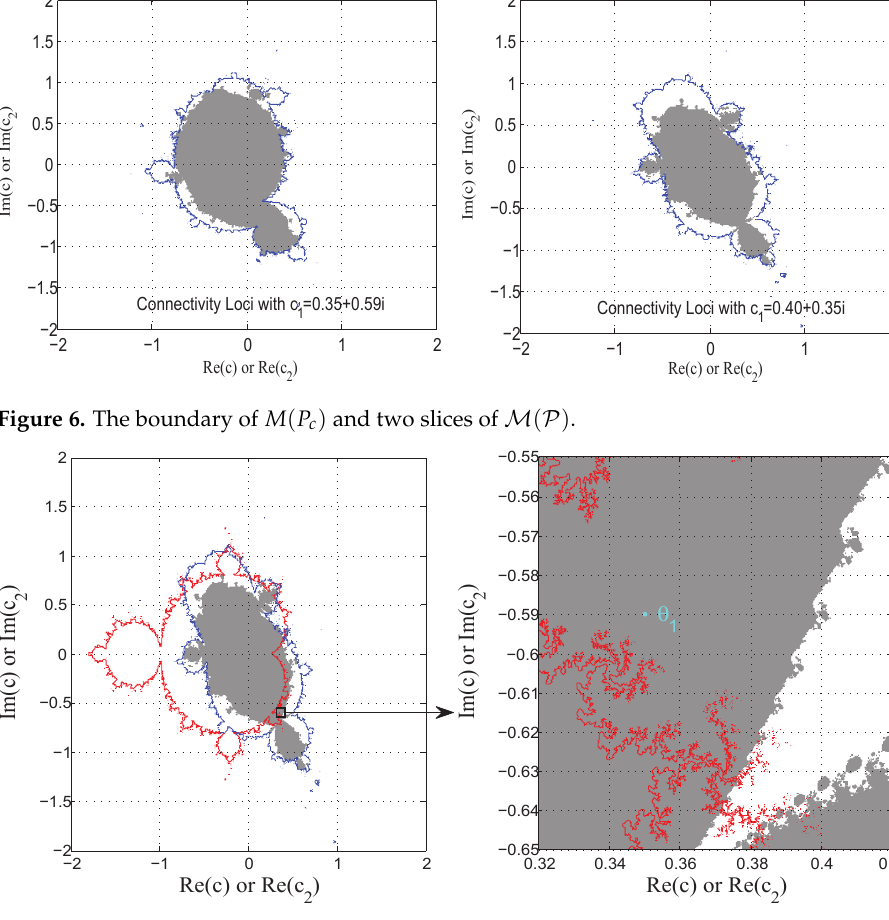
Figure 7. The detail of M ( P ) with c 1 = 0.35 + 0.59 i .